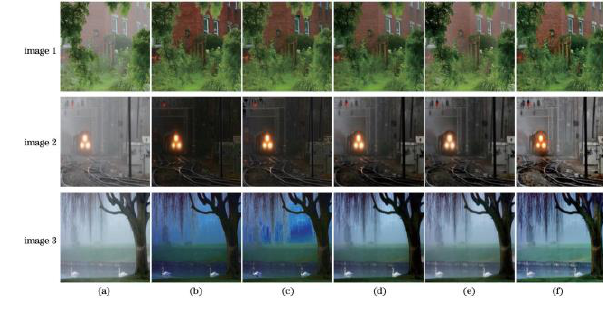
Figure 4. Effect of different algorithms for processing alternating near-and-far images. (a) Original images;(b) Ref. [7] ; (c) Ref. [8] ; (d) Ref.